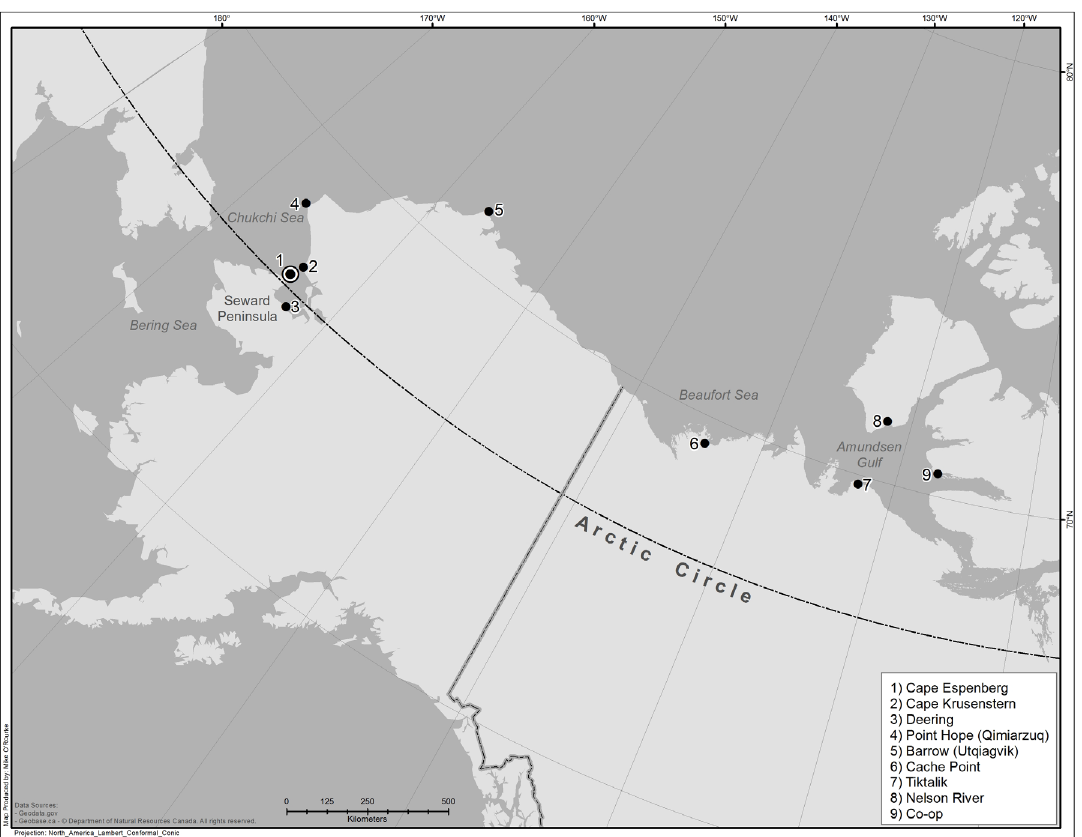
Figure 1: Location of Cape Espenberg and other sites from the